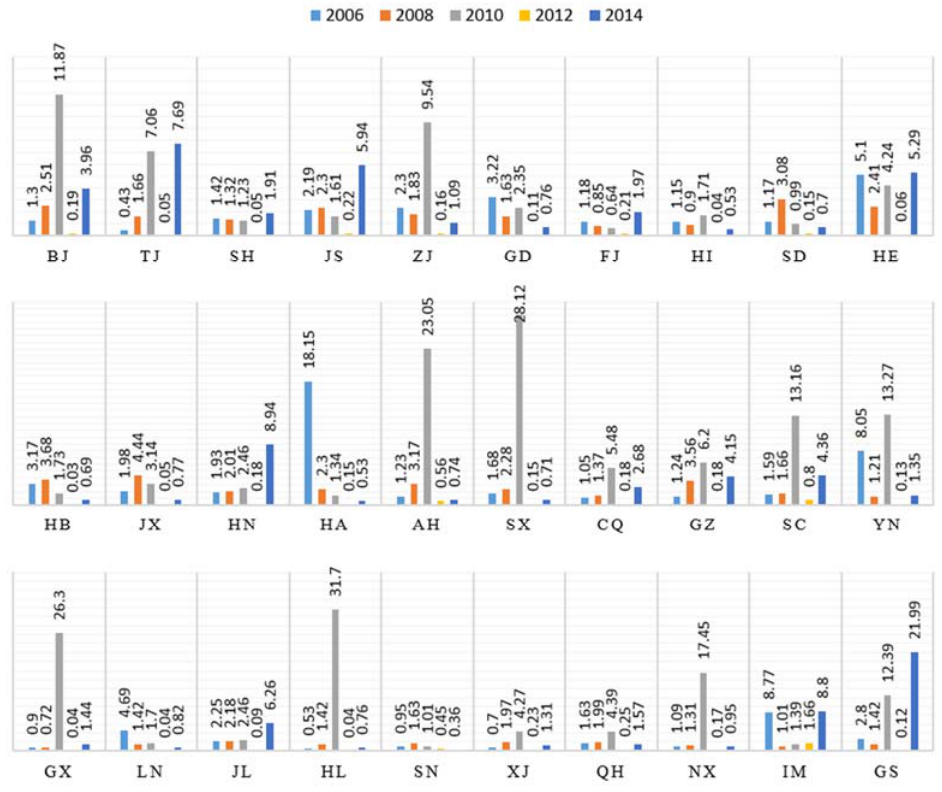
Figure 4. Contributions of output scale effect of 30 provinces in 2006, 2008, 2010, 2012 and 2014.